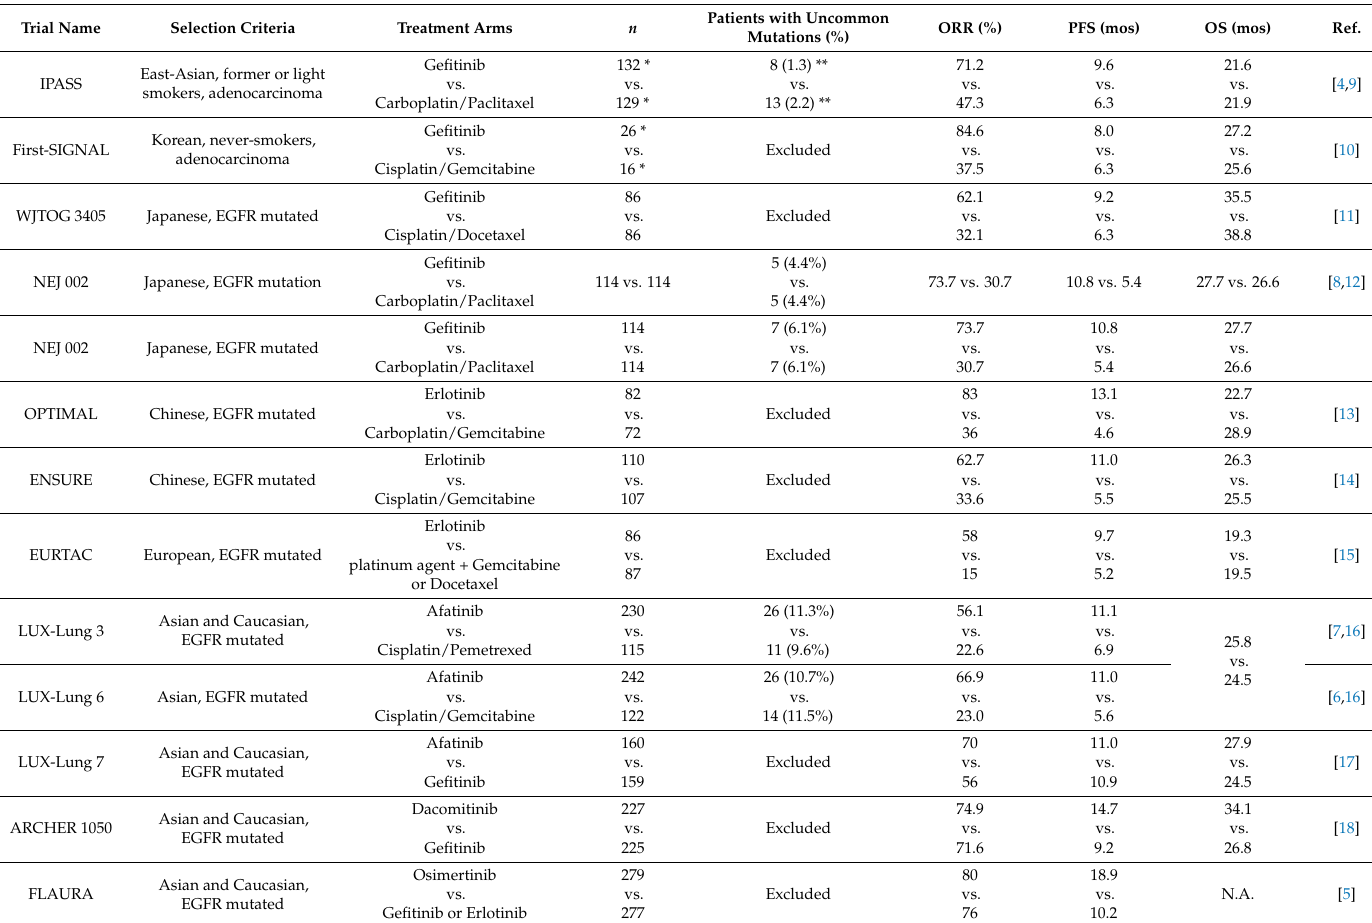
Table 1. Phase IIb/III trials evaluating three generations of Epidermal Growth Factor Receptor (EGFR) tyrosine kinase inhibitors (TKIs) in the first-line setting, either compared with platinum-based chemotherapy or other EGFR